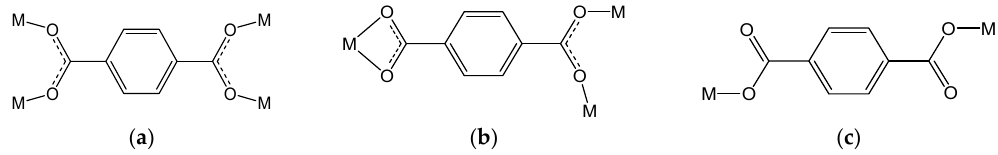
Scheme 2. Coordination modes of ( a ) bis -bidentate, ( b ) chelating/bidentate, and ( c ) bis -monodentate of bdc 2 − ligand used in compounds 1 – 4 .